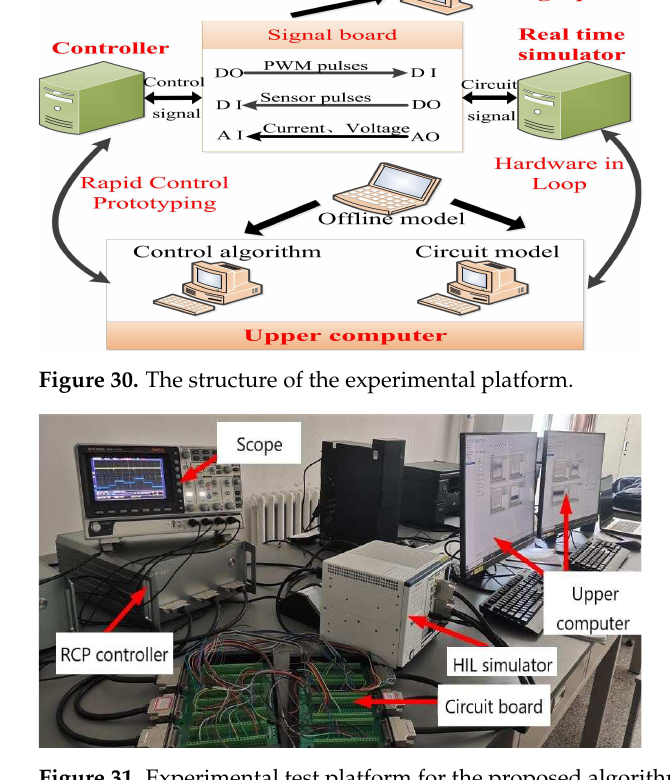
Figure 31. Experimental test platform for the proposed